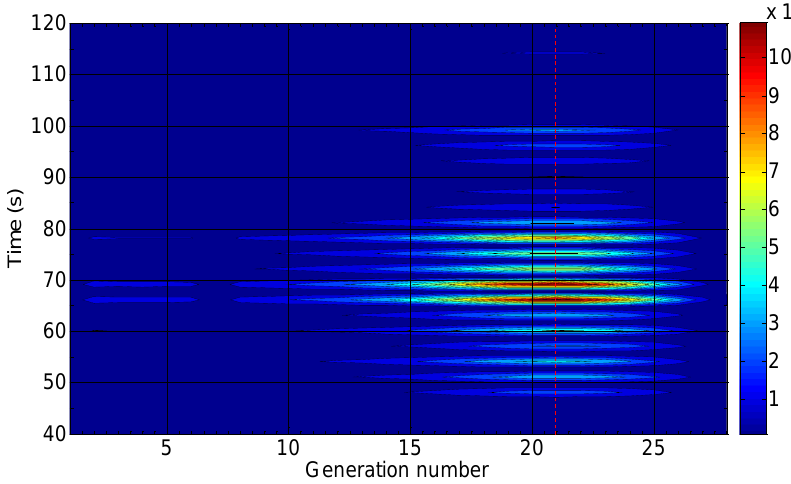
Figure 7. Contour plot showing the particle deposition for each generation number during a welding process: maximum deposition at the 21st generation 8.93 × 10 9 particles ( D G : total particle number dose deposited in the Gth